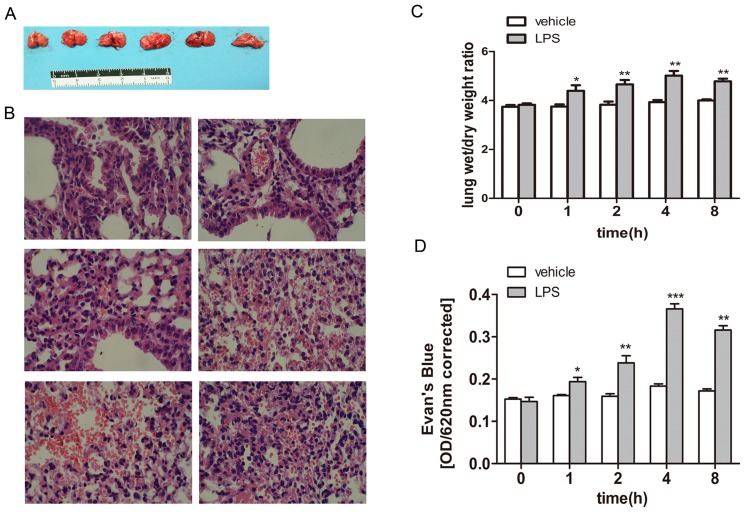
LPS induced acute lung injury model via repressing lung barrier function in Balb/c(×400).(A) 10 Balb/c mice were randomly divided into two groups with five mice per group. The mice in the experimental group were peritoneally injected with 0.01 mg/g LPS fluid per mouse to model ALI, whereas the mice in the control group were injected with the same dose of saline. After 0–8 hours of stimulation, the left lung tissues of each mouse were carefully separated, as shown at the macroscopic level. (B) The specimens were then fixed in 4% paraformaldehyde for HE staining, as shown at the microscopic level. Images taken at ×400 (G) (C) after LPS induction, and all right lung tissues were separated and placed on filter paper to measure their wet weight. The tissues were then placed in a 60°C thermotank for 24 hours to obtain the dry weight. The W/D (weight/dry) data are shown in the bar graph. Compared with the 0 hour group (control group), the W/D value increased significantly by 17.1%, 21.4% and 27.5% at 1 hour, 2 hours and 4 hours, respectively. However, the absolute W/D value began to decrease at 8 hours compared with the 4-hour value, but this difference was insignificant. (D) After LPS induction, the lung barrier function was assayed using the Evans blue dye extra-barrier technique to determine the integrity of the alveolar epithelium integrity. Balb/c mice were injected with 0.01 mg/g Evans Blue per mouse in the tail vein 30 minutes before execution. The absorbance of Evans Blue was detected in an ultraviolet spectrophotometer at 620 nm, as shown in the bar graph. The absorbance value began to increase at 1 hour compared with the vehicle group. The value increased over time. The absorbance value reached its peak at 4 hours and decreased somewhat at 8 hours compared with the 4-hour value, but the difference was not significant. The test was repeated three times with identical results. The data are presented as the mean ± SEM. *p<0.05, **p<0.01, ***p<0.001 vs. vehicle control.